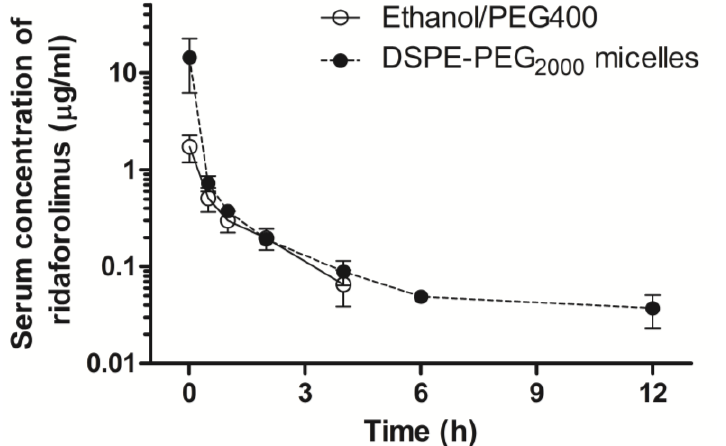
Figure 5. Concentration-time profile in serum of ridaforolimus after intravenous administration of control ridaforolimus formulation in ethanol/PEG 400 and ridaforolimus in DSPE-PEG micelles. The dose for all the formulations was 10 mg/kg to rats 2000 (mean ± SEM, n = 7 per